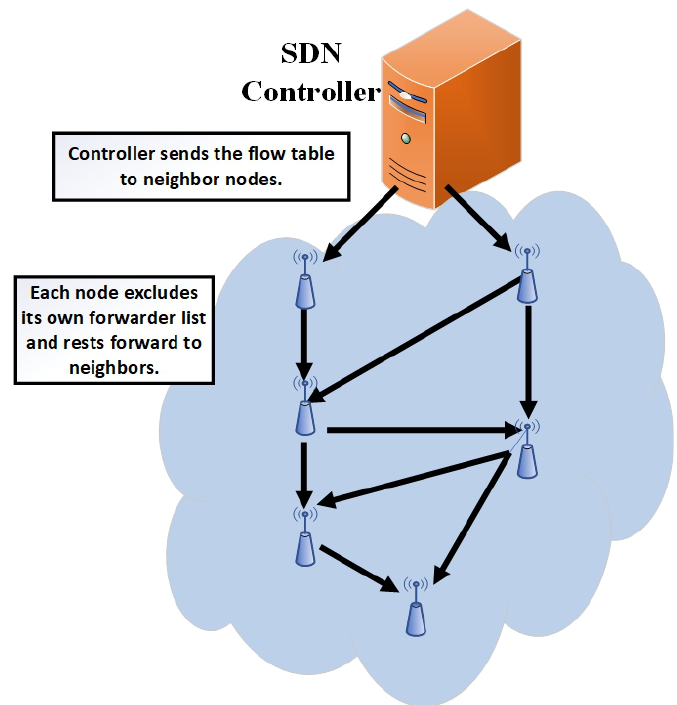
Figure 5. Received flow table.